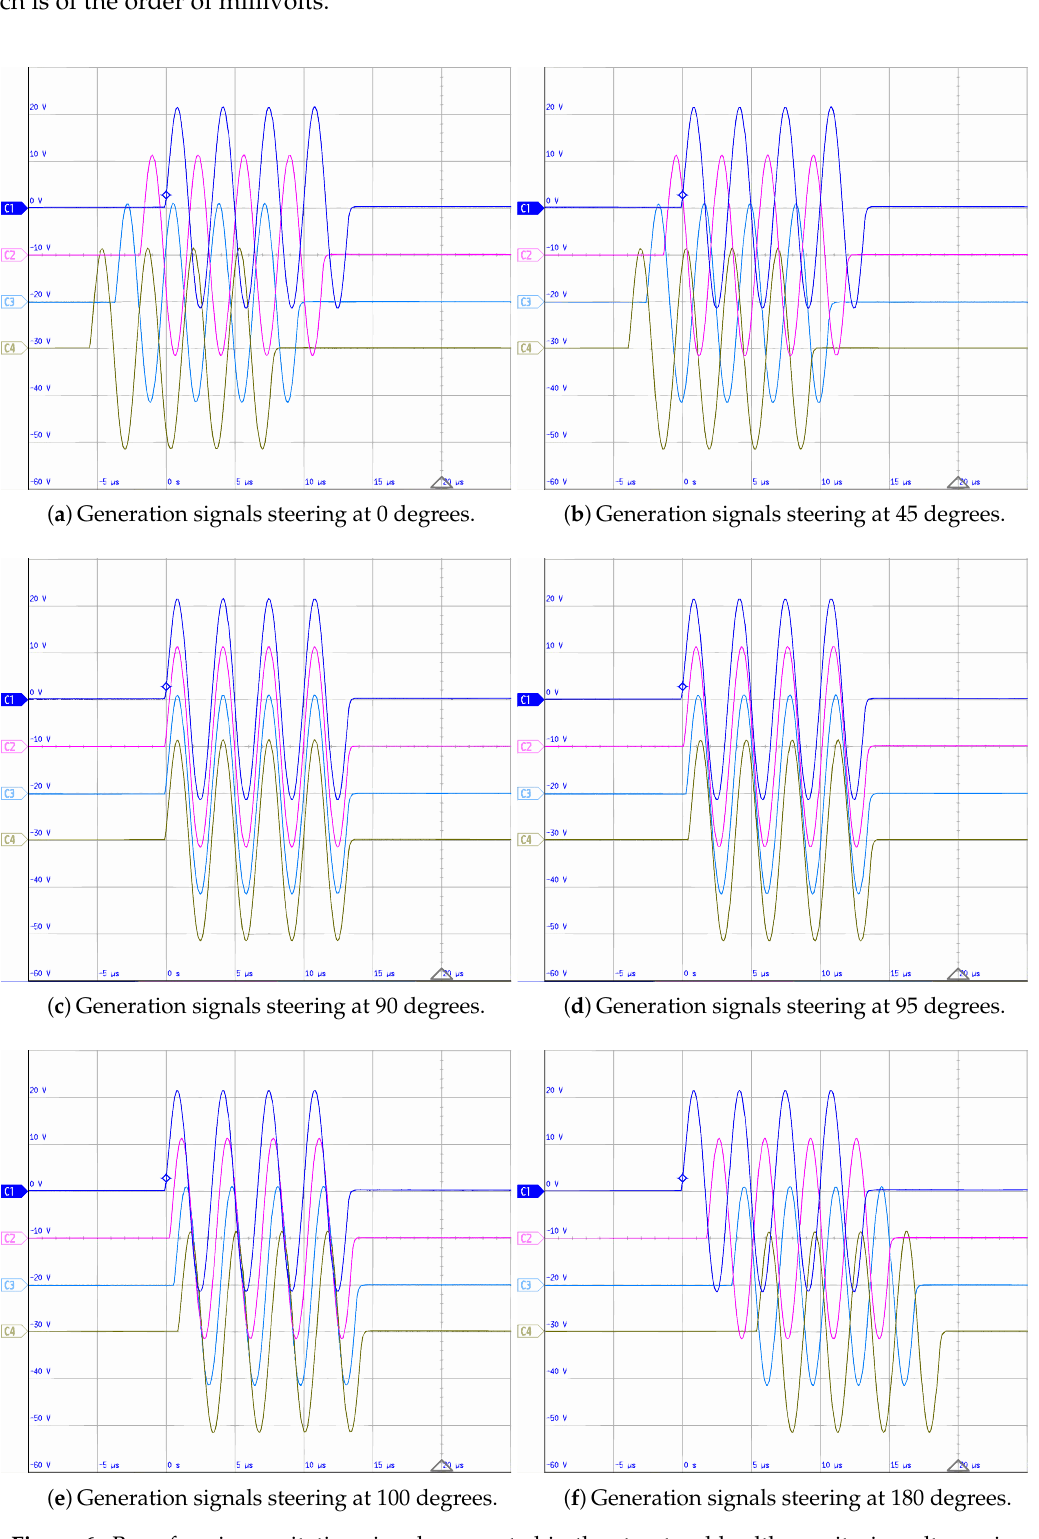
Figure 6. Beamforming excitation signals generated in the structural health monitoring ultrasonic system (SHMUS) and digitized with an oscilloscope. The horizontal axes represent the time with 5 µs/div while the vertical ones show the voltage amplitude with 10